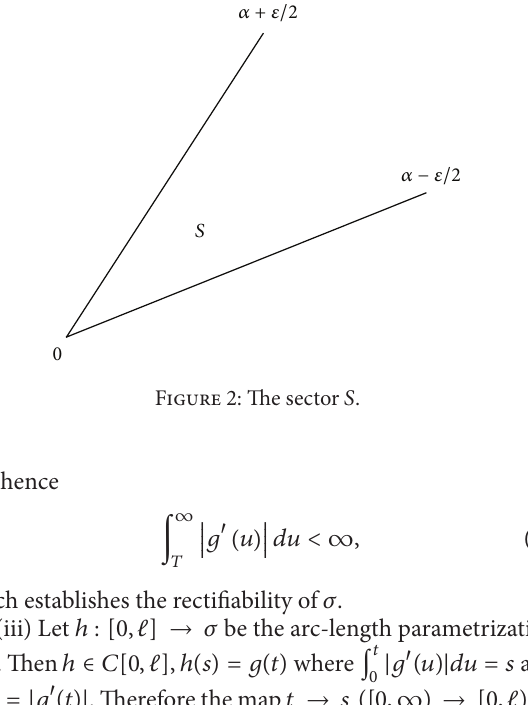
Figure 2: The sector 𝑆